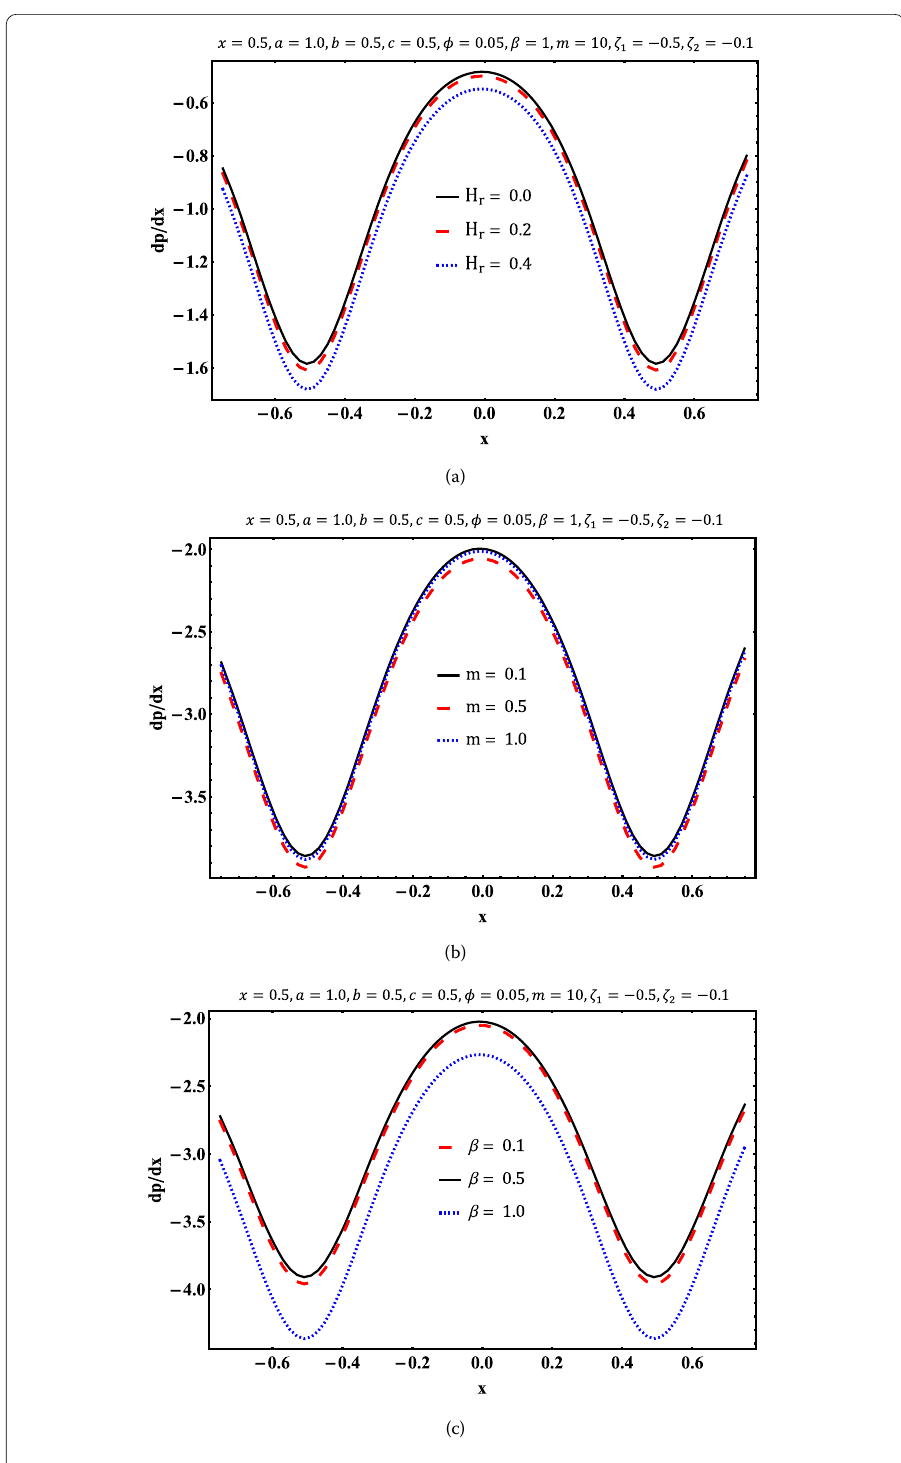
Figure 3 Pressure gradient distribution vs. ( a ) H r , ( b ) m , ( c ) β , ( d ) ζ 1 , and ( e ) ζ 2 .